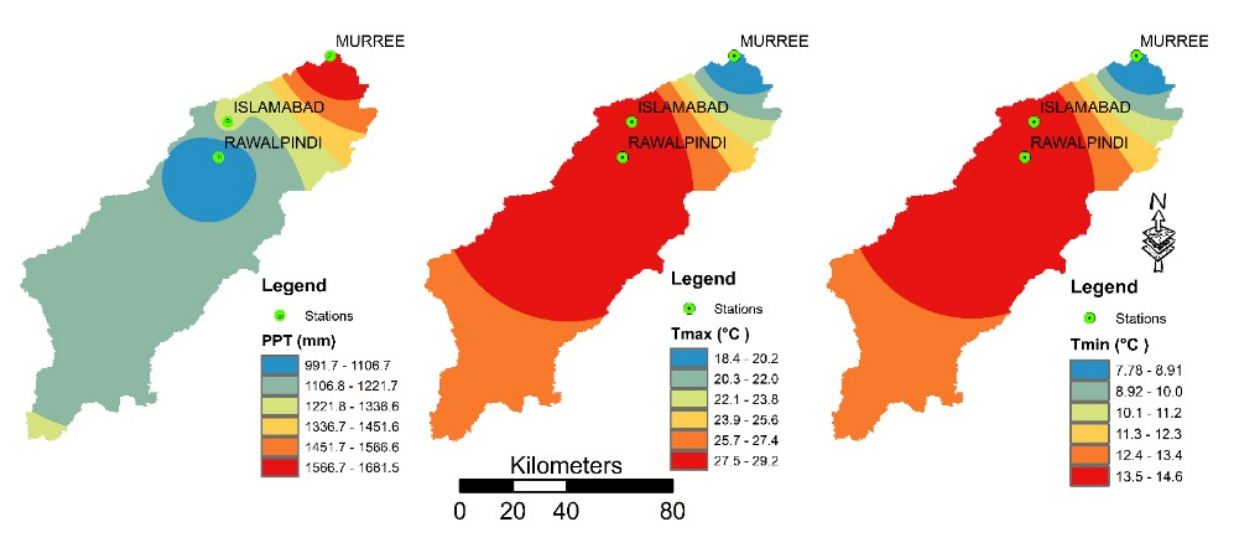
Figure 1. Study area map.